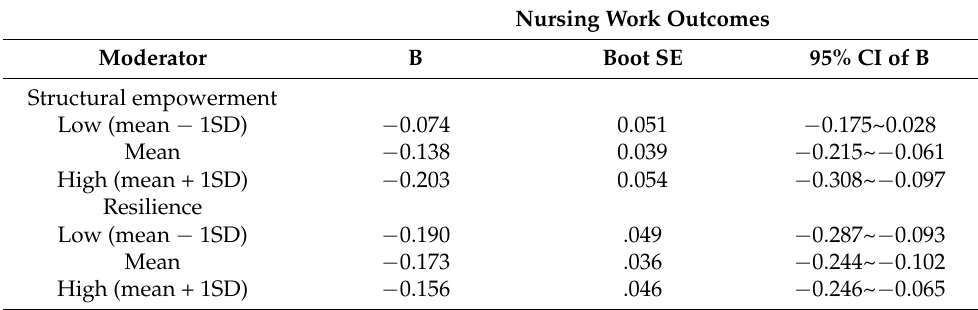
Table 4. The moderating effect of structural empowerment and resilience according to conditional values in the relationship between workplace bullying and nursing work outcomes ( n =